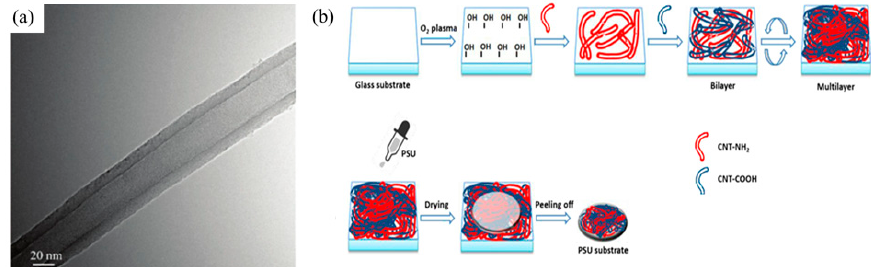
Figure 5. ( a ) TEM image of CNTs [73]; ( b ) representation of the layer-by-layer schematic process and multilayer transfer process [88].